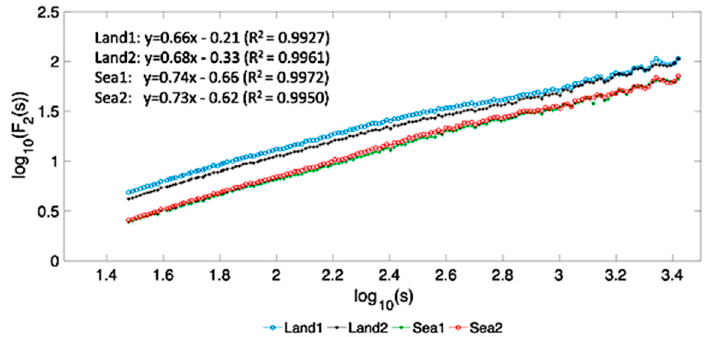
Figure 4. Log-log plots of F 2 (s) for two grid points located over land (Land1: 39.75 ◦ N, 21.75 ◦ E, Land2: 37.50 ◦ N, 22.50 ◦ E) and for two points located over sea (Sea1: 35.25 ◦ N, 27.75 ◦ E, Sea2: 36.75 ◦ N, 21.00 ◦ E) along with the linear fit equations and the corresponding coefficient of determination R 2 values.